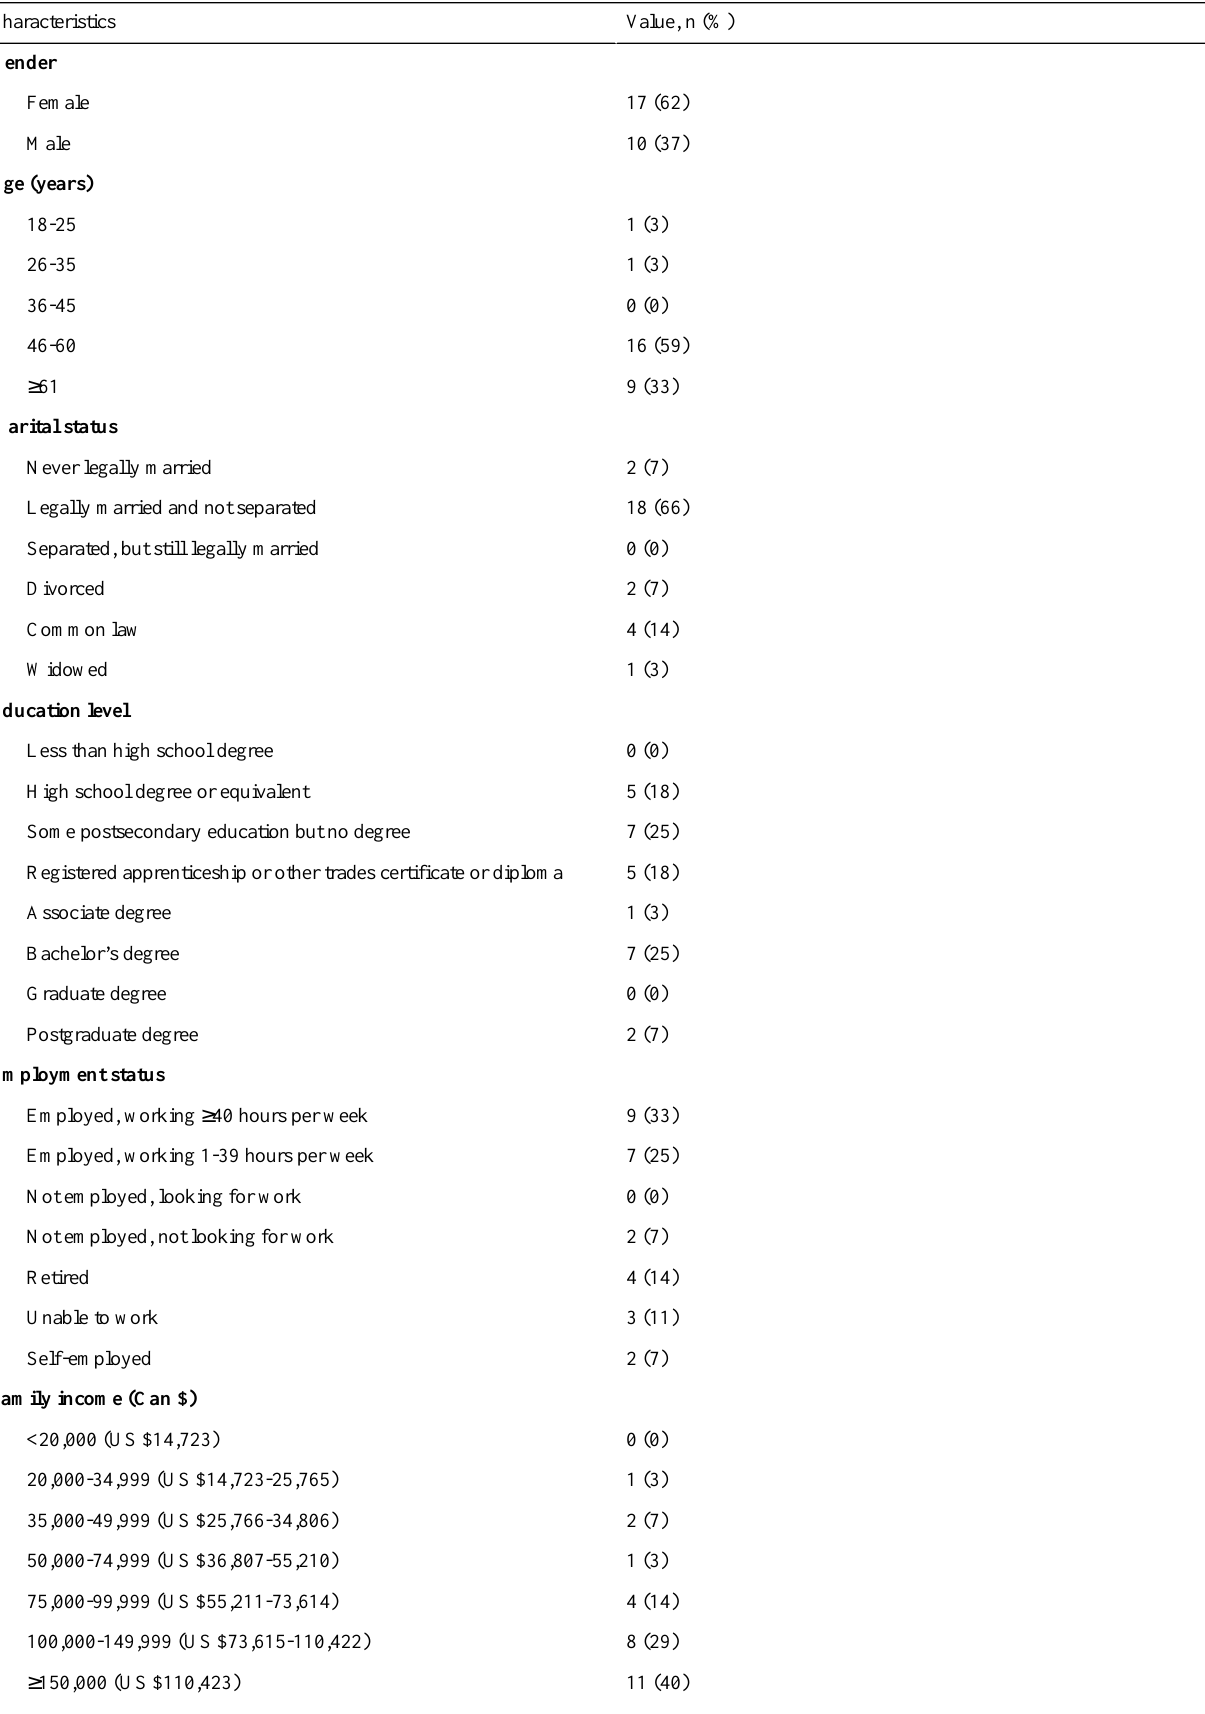
Table 2. Demographics of patient respondents and the reported conditions